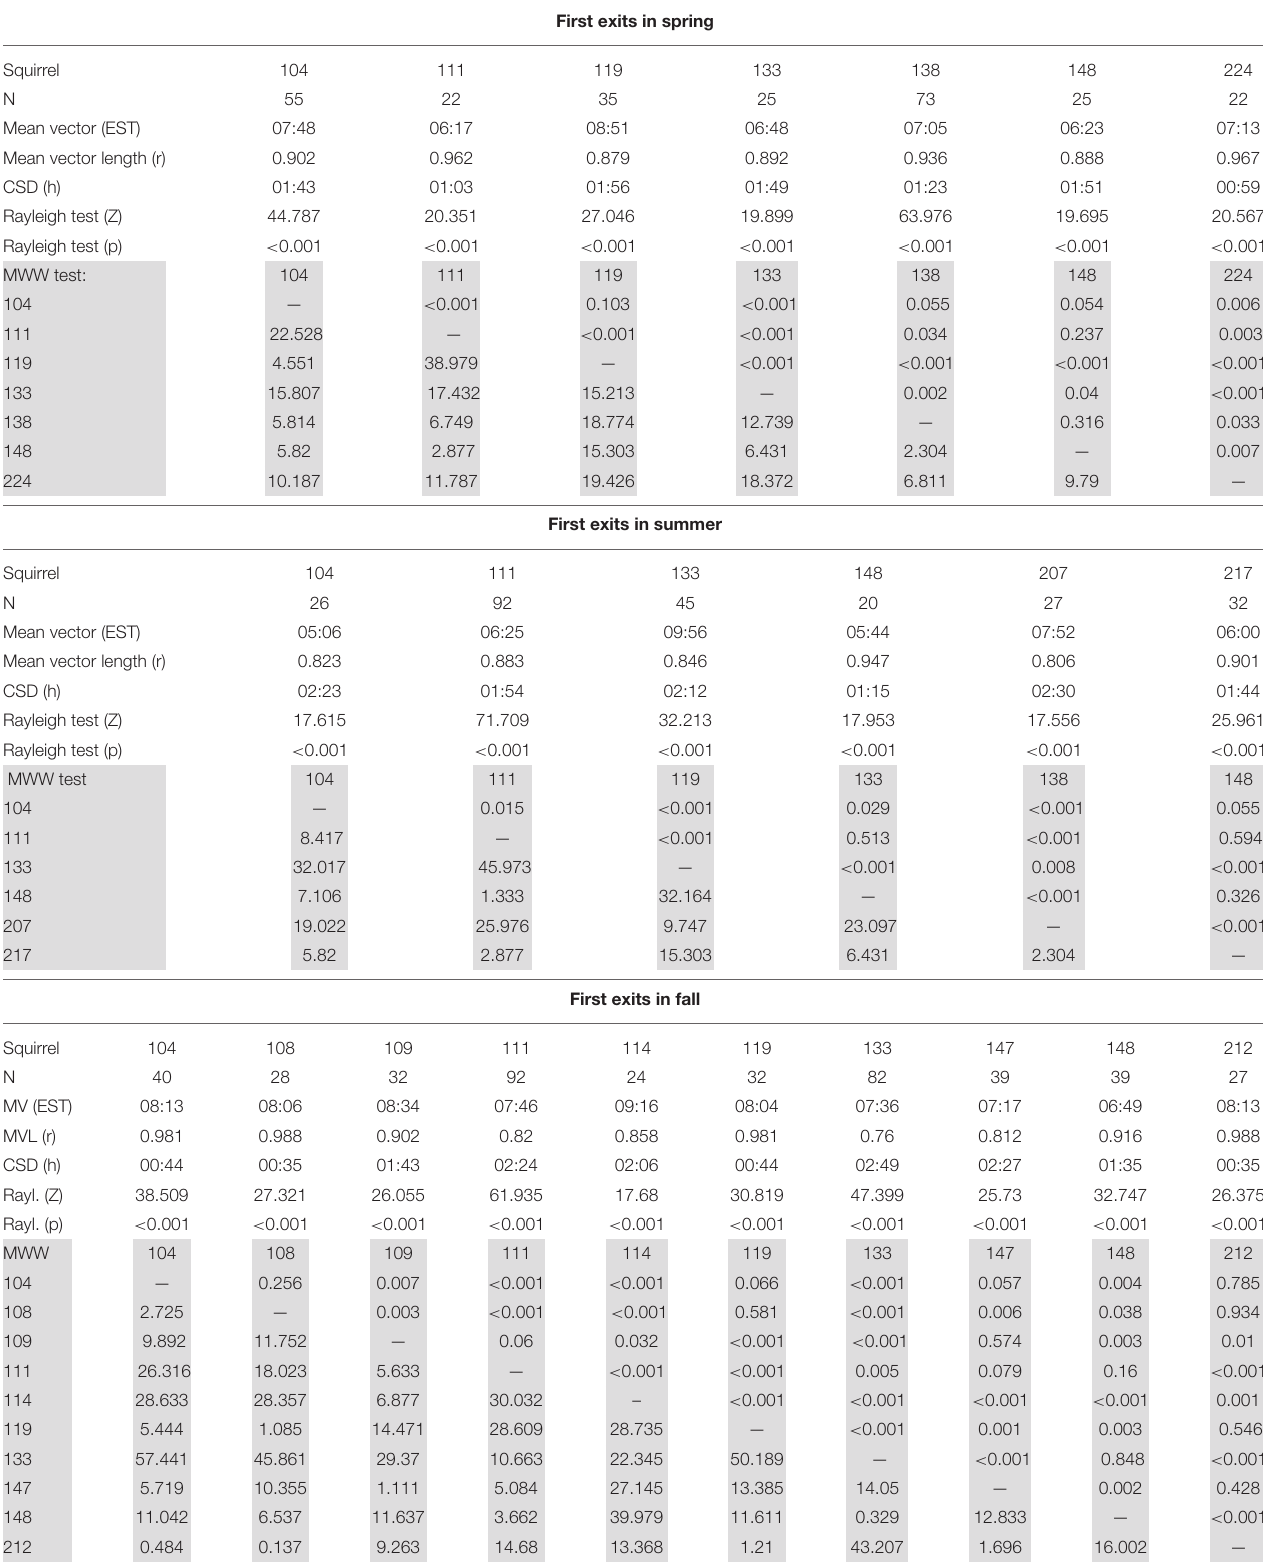
TABLE 3 | Circular statistics of the seasonal timing of first exits in individual squirrels.